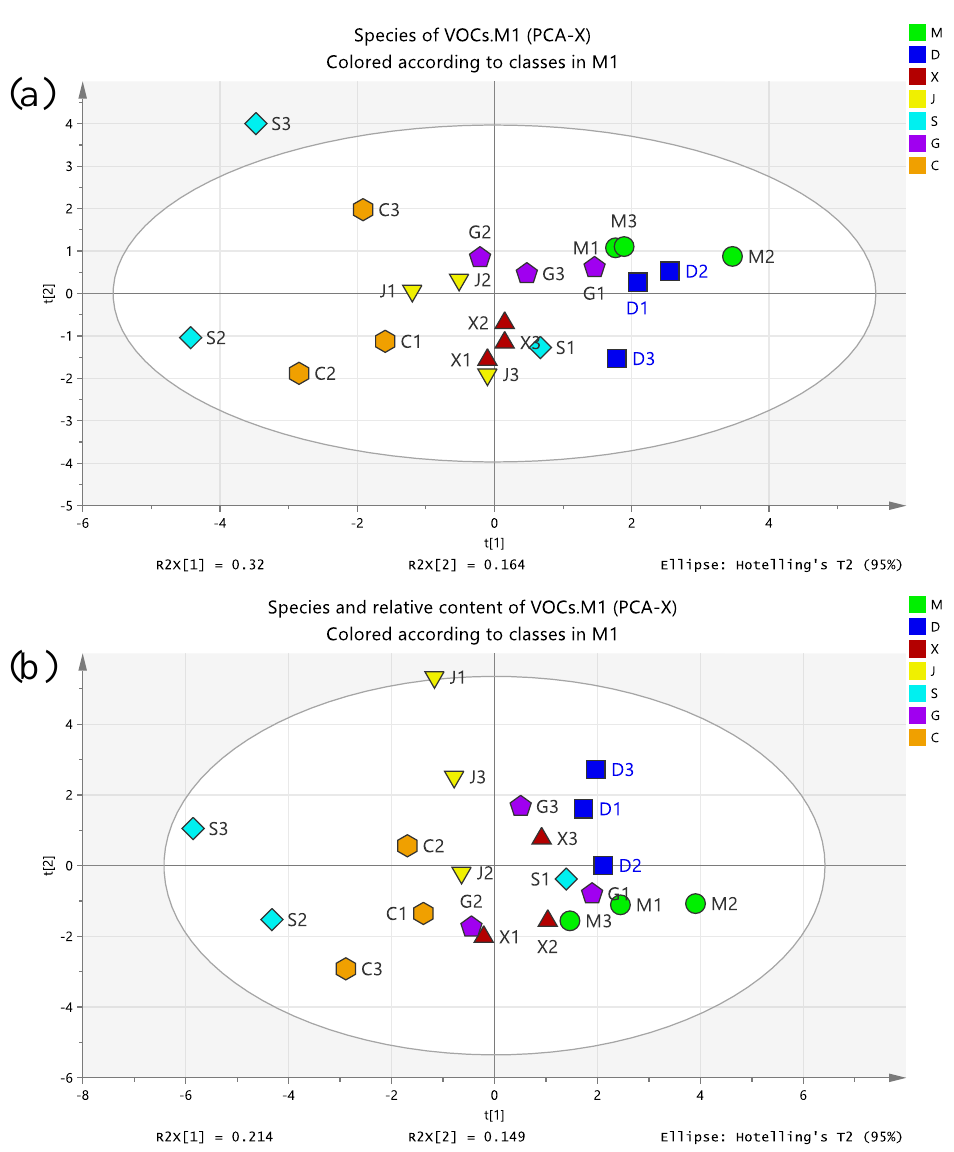
Figure 3. PCA-X diagram based on species ( a ) and ‘species + relative content’ ( b ) of VOCs from seven regions.